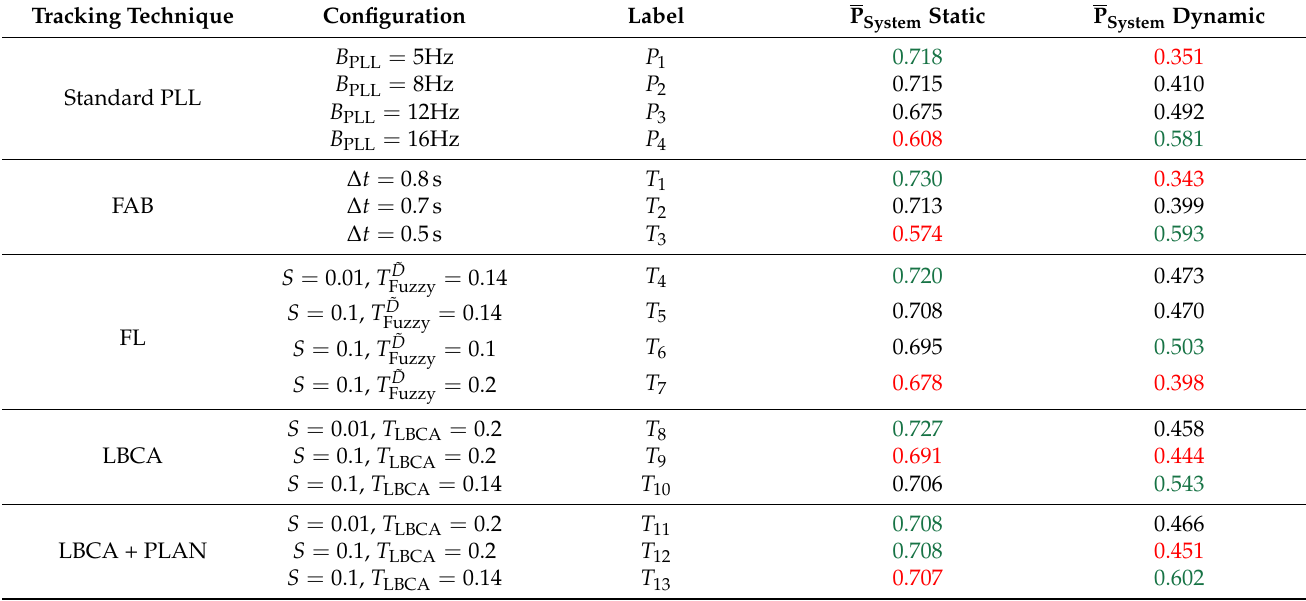
Table 6. System performance of adaptive tracking techniques. Tracking Technique